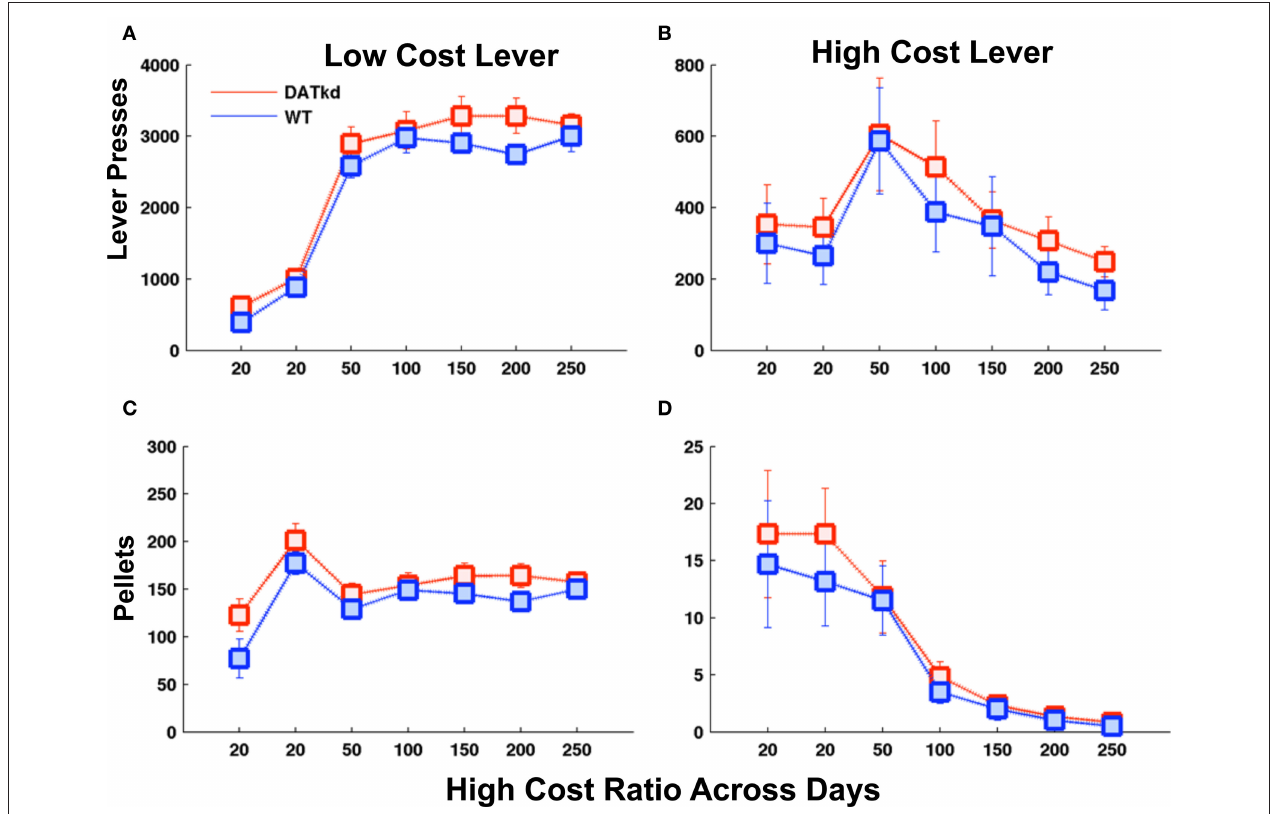
Figure 4 | effort and earned rewards when the price of the high and low cost levers does not switch. Average lever presses on the (A) low cost and (B) high cost lever and average pellets earned on (C) low and (D) high cost levers as the price of the high cost lever increases across days. No significant genotype differences across panels. Error bars = S.E.M, N =